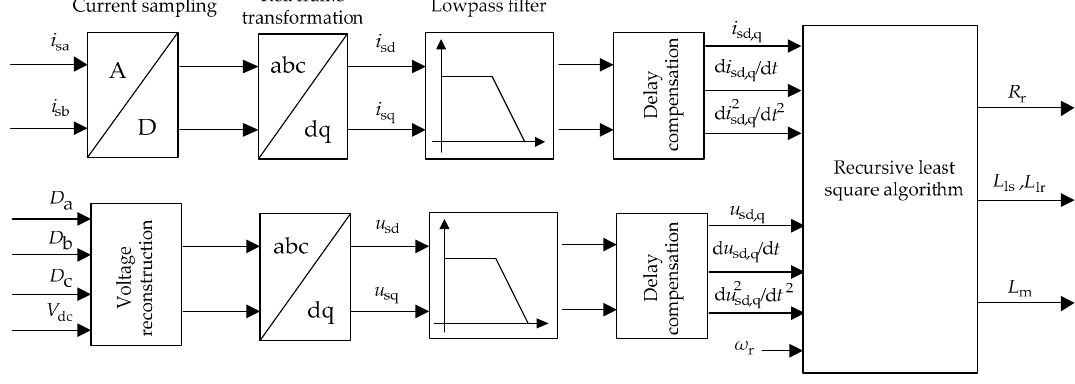
Figure 5. Implementation of the RLS algorithm for online parameter identification.